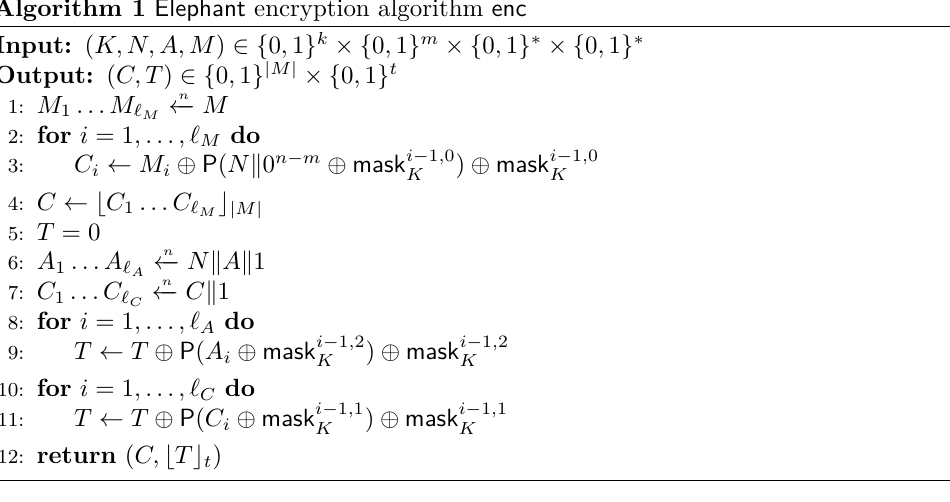
Algorithm 1 Elephant encryption algorithm enc